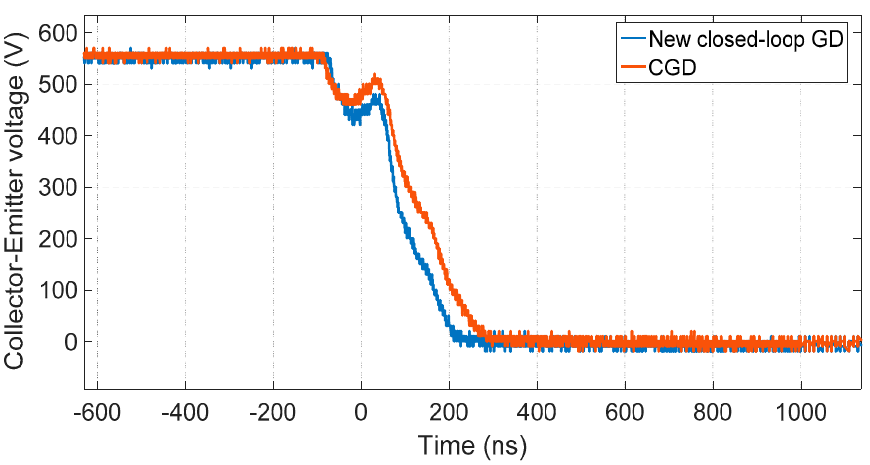
Figure 7. The resultant v CE from closed-loop GD and CGD at turn-on condition.